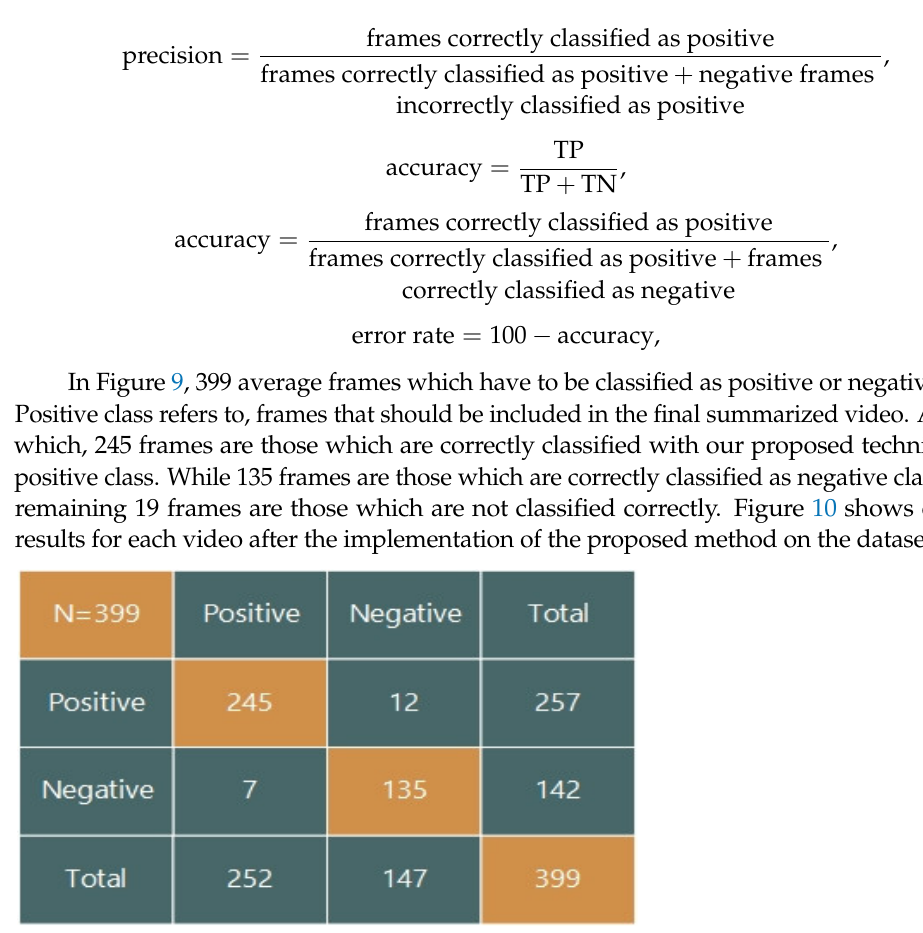
Table 3. Performance comparison of the proposed method with existing